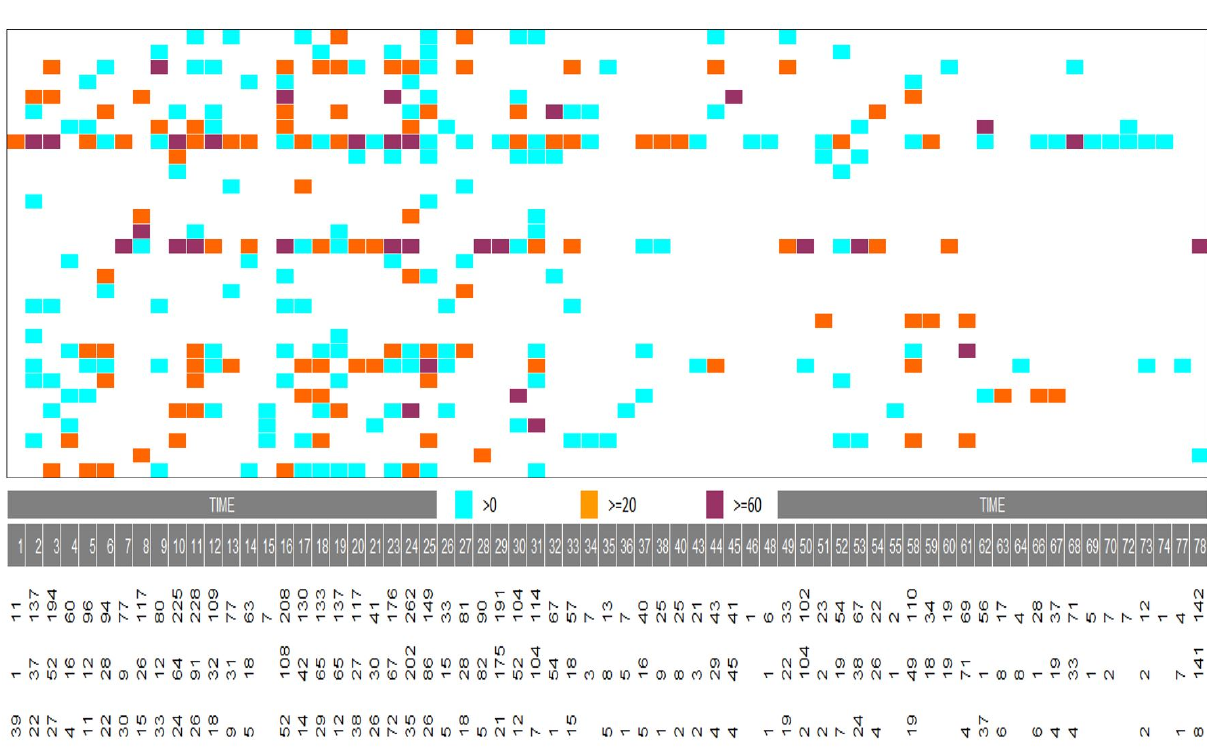
Figure 7. The viewpoints emitted by the 30 guests during the 78 days of the experiment. Each colored square illustrates the number of viewpoints emitted by a guest (anonymized pseudo on the vertical axis) for one day (number of the day on the horizontal time line): “blue” means 1 or more viewpoints emitted, orange means 20 or more, violet means 60 or more.